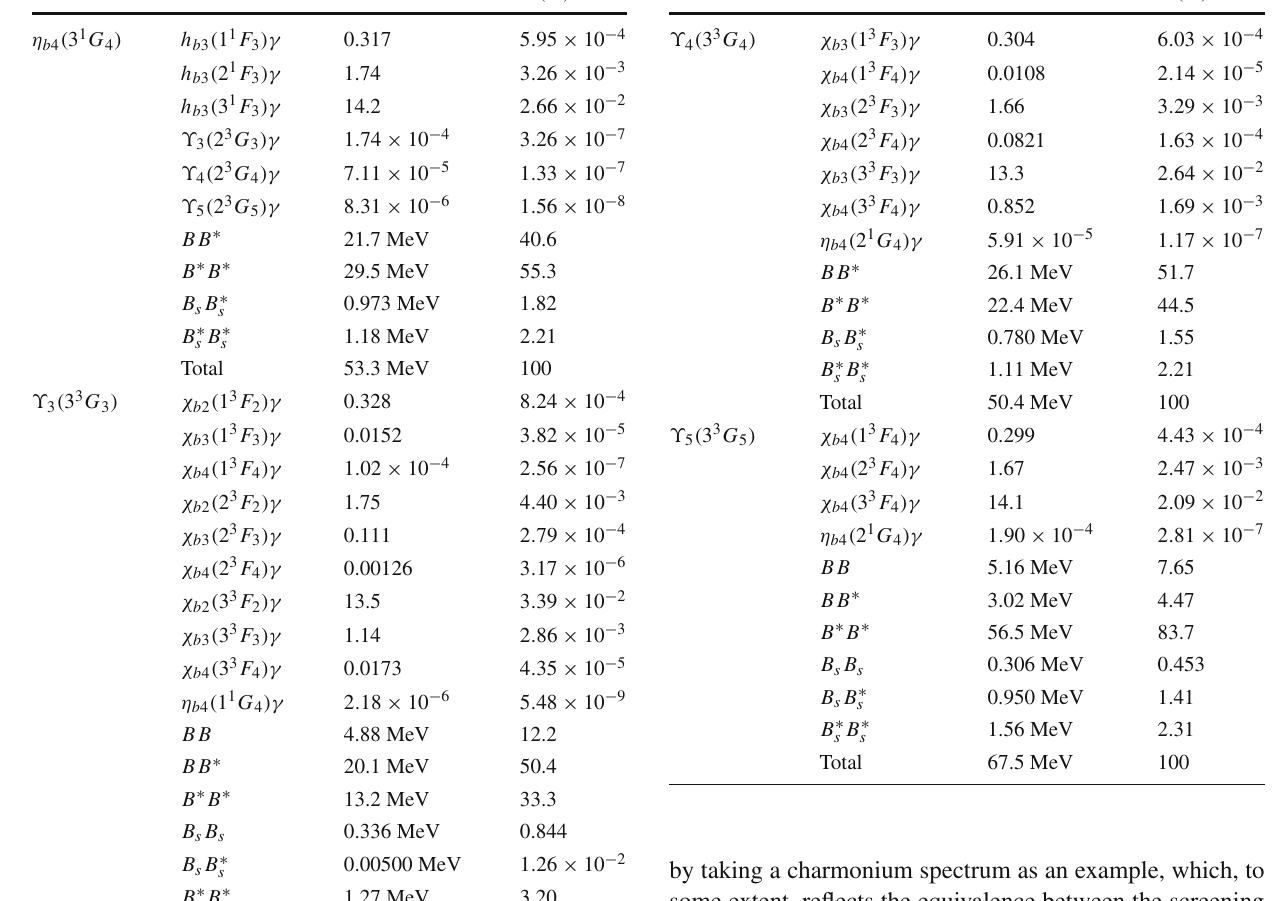
Table39 PartialwidthsandbranchingratiosoftheOZI-allowedstrong decay, and radiative transition and the total widths for 3 1 G 4 and 3 3 G 3 bottomonium states. The width results are in units of keV State